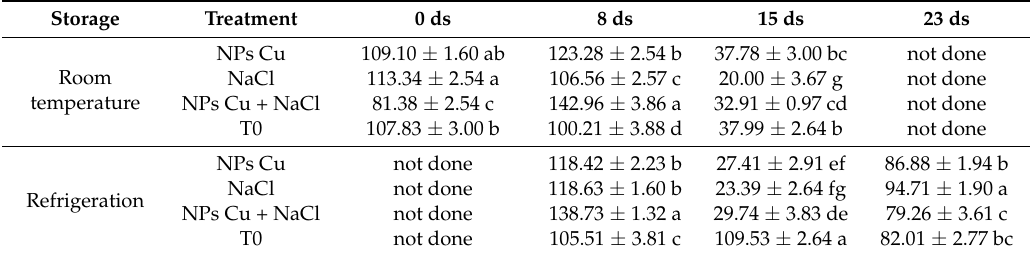
Table 2. Flavonoid content (milligrams equivalent of quercetin per 100 g dry weight) in tomato fruits at different storage times at room temperature (24 ± 1 ◦ C) and refrigeration (4 ± 1 ◦ C and relative humidity of 80%).